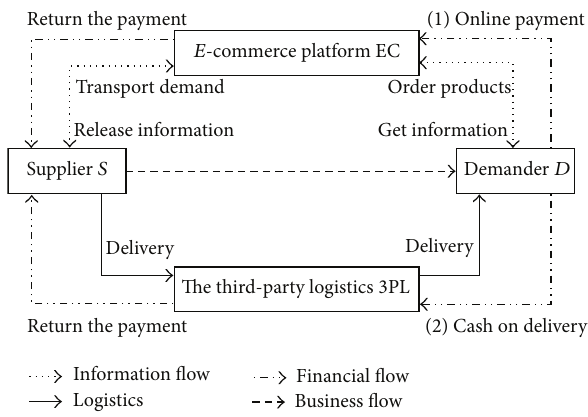
Figure 1: The supply chain model under e-commerce environment.